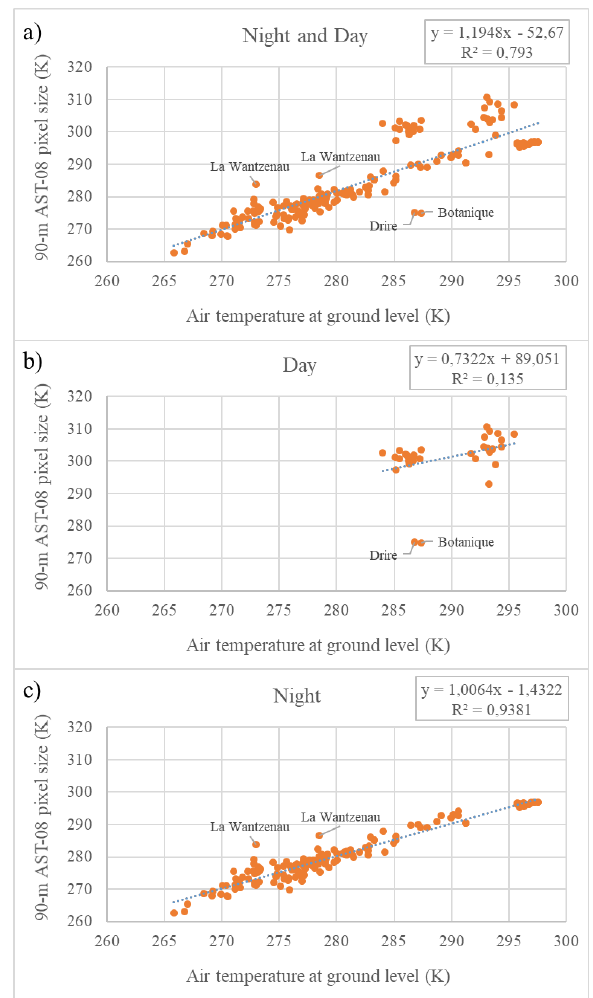
Figure 4. a) Correlation between pixel-based AST-08 and air temperatures at ground level for all satellite products available both day and night between 2012-2019, b) same correlations